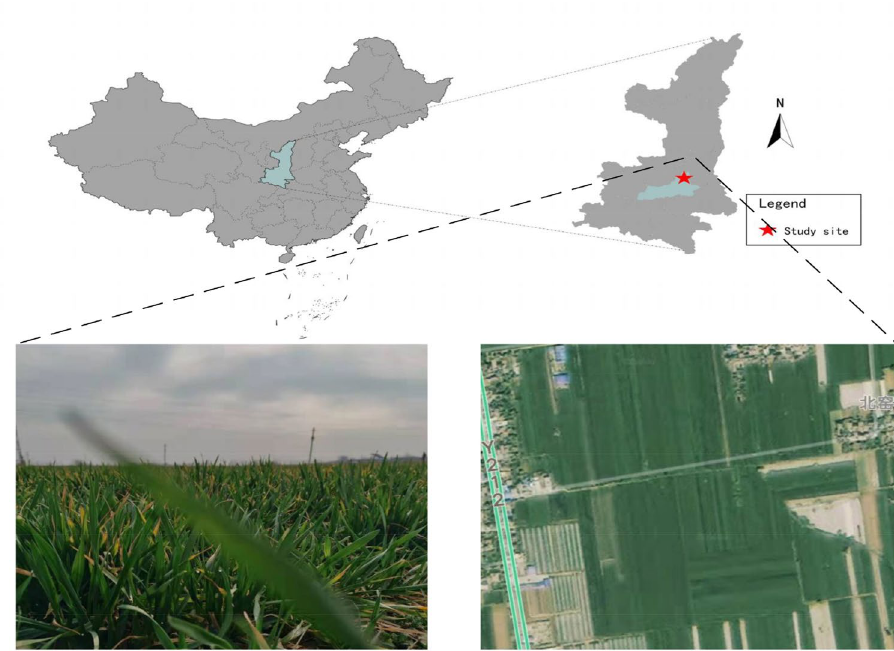
Figure 1. Location of the field of study (The satellite imagery supporting this study was obtained using Baidu Maps (Android version—16.4.0.1195). The URL is (https:// map. baidu. com/@ 14256 795. 56841 0998,52106 75. 60626 8121,8. 67z.).